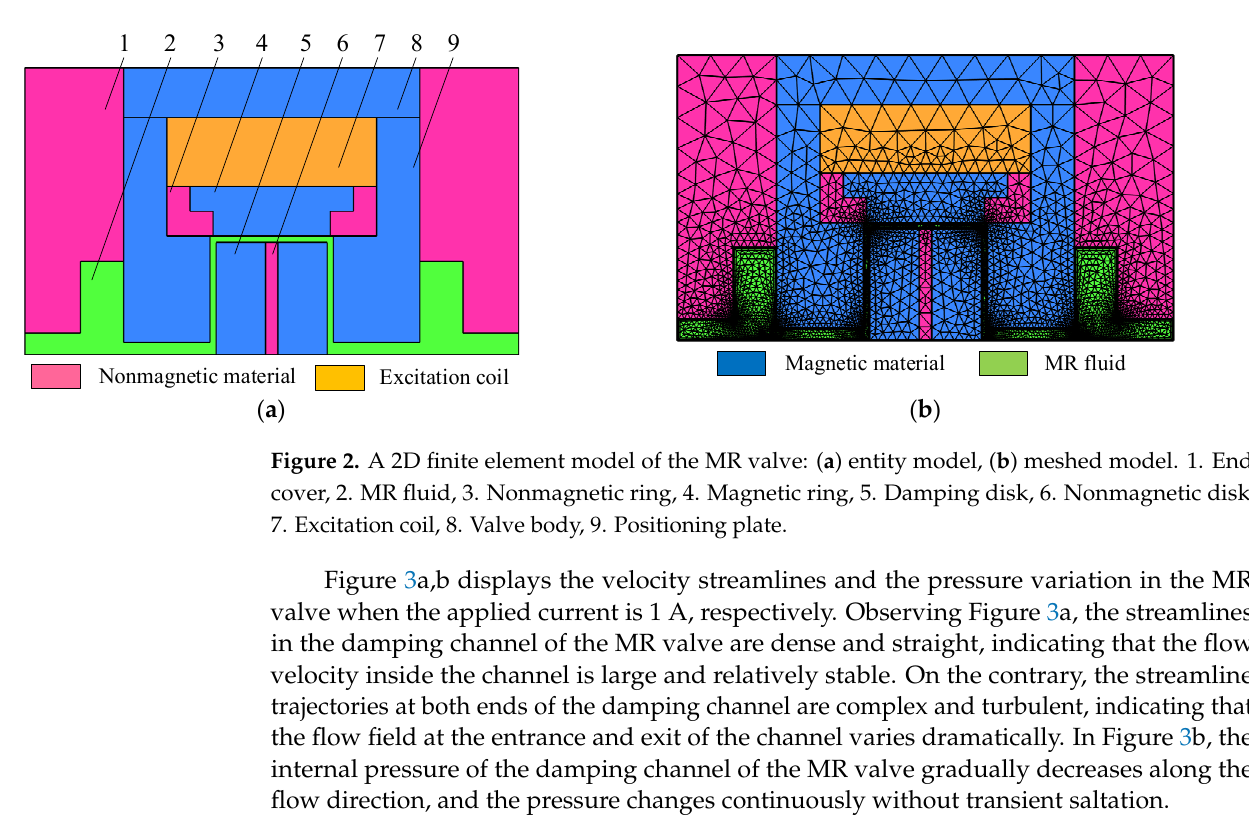
Figure 3. Internal flow field distribution of the MR valve: ( a ) velocity streamlines, ( b ) pressure.